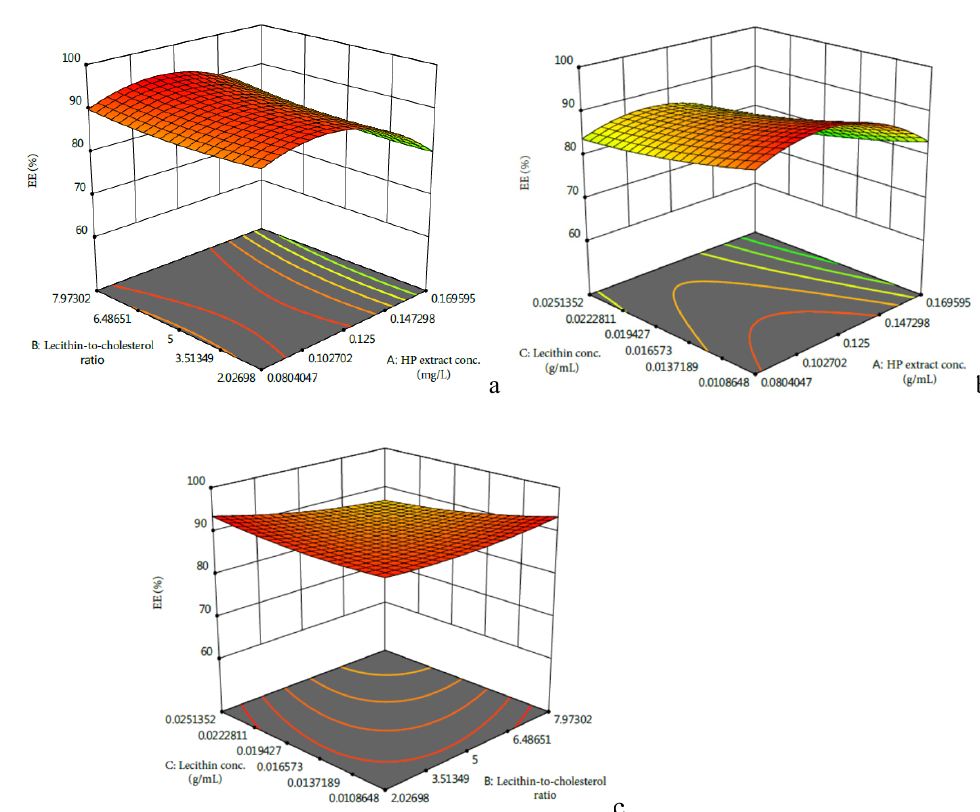
Figure 1. Response surface plots showing the effects of HP extract concentration, lecithin-to-cholesterol ratio, and lecithin concentration on the EE of HPBL: ( a ) interactive relationships between HP extract concentration and lecithin-to-cholesterol ratio; ( b ) interactive relationships between HPextract concentration and lecithin concentration; ( c ) interactive relationships betweenlecithin-to-cholesterol ratio and lecithin concentration.